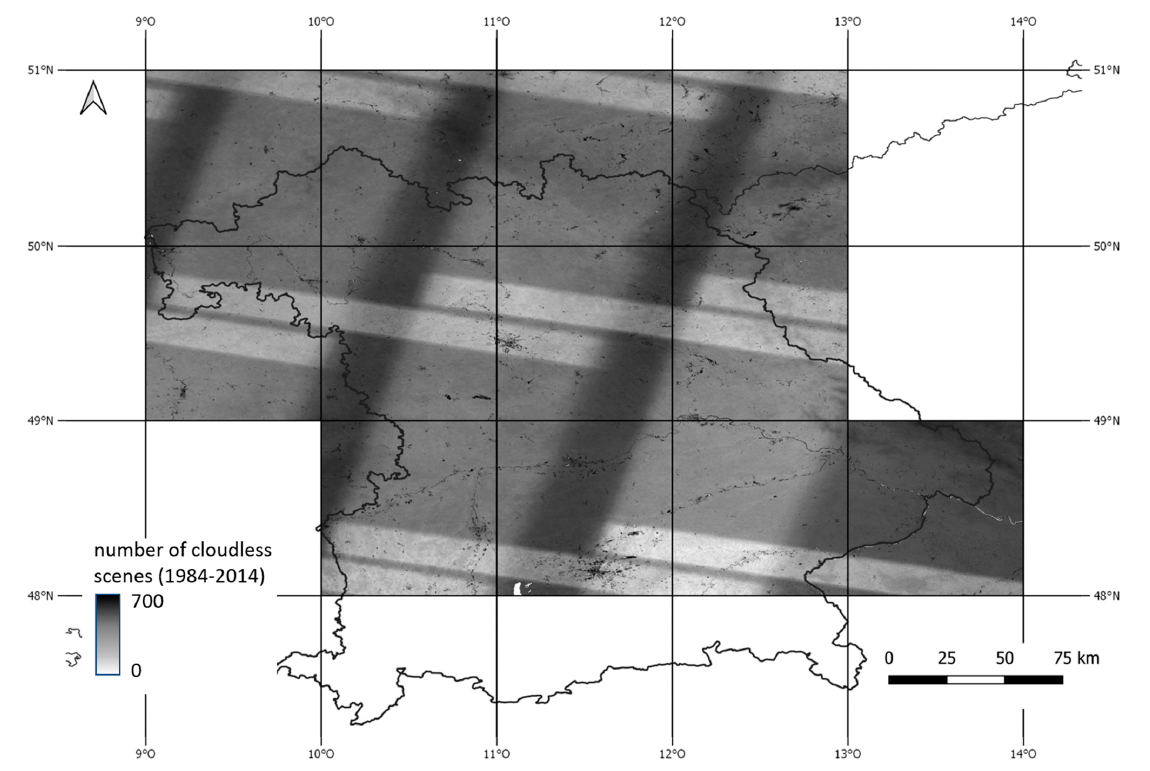
Figure A1. The number of cloudless scenes per pixel for the total composite time (1984–2014) in the investigation area.